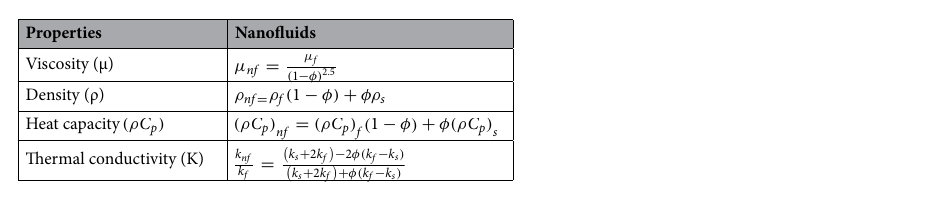
Table 1. Thermophysical properties of Nanofluids.